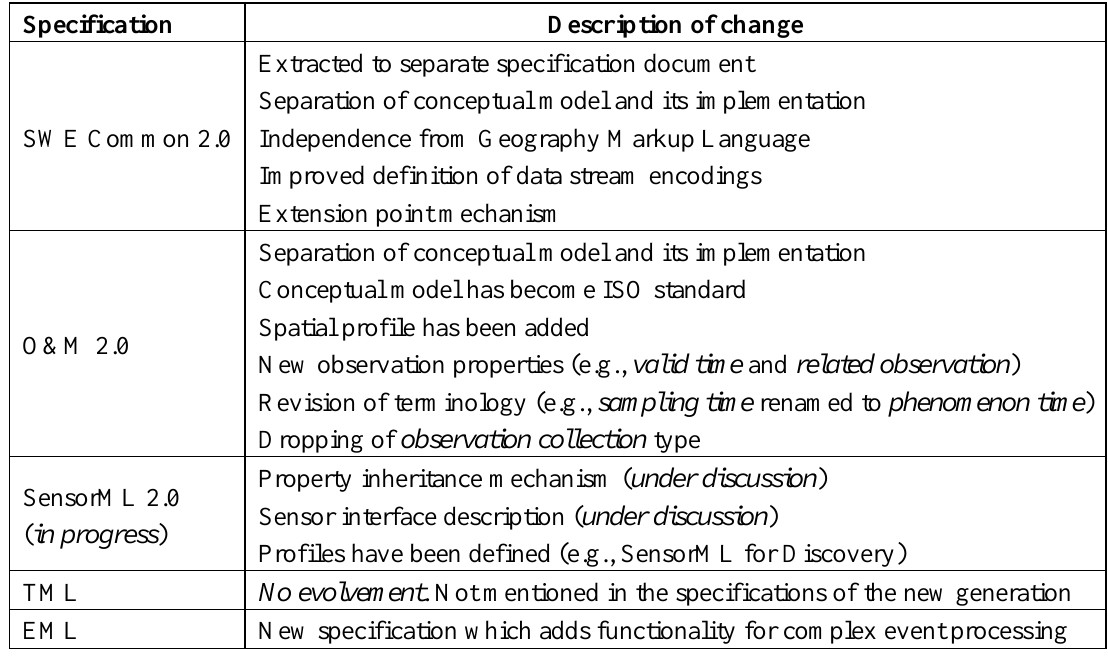
Table 1. Major changes from the first to the new generation of the SWE information